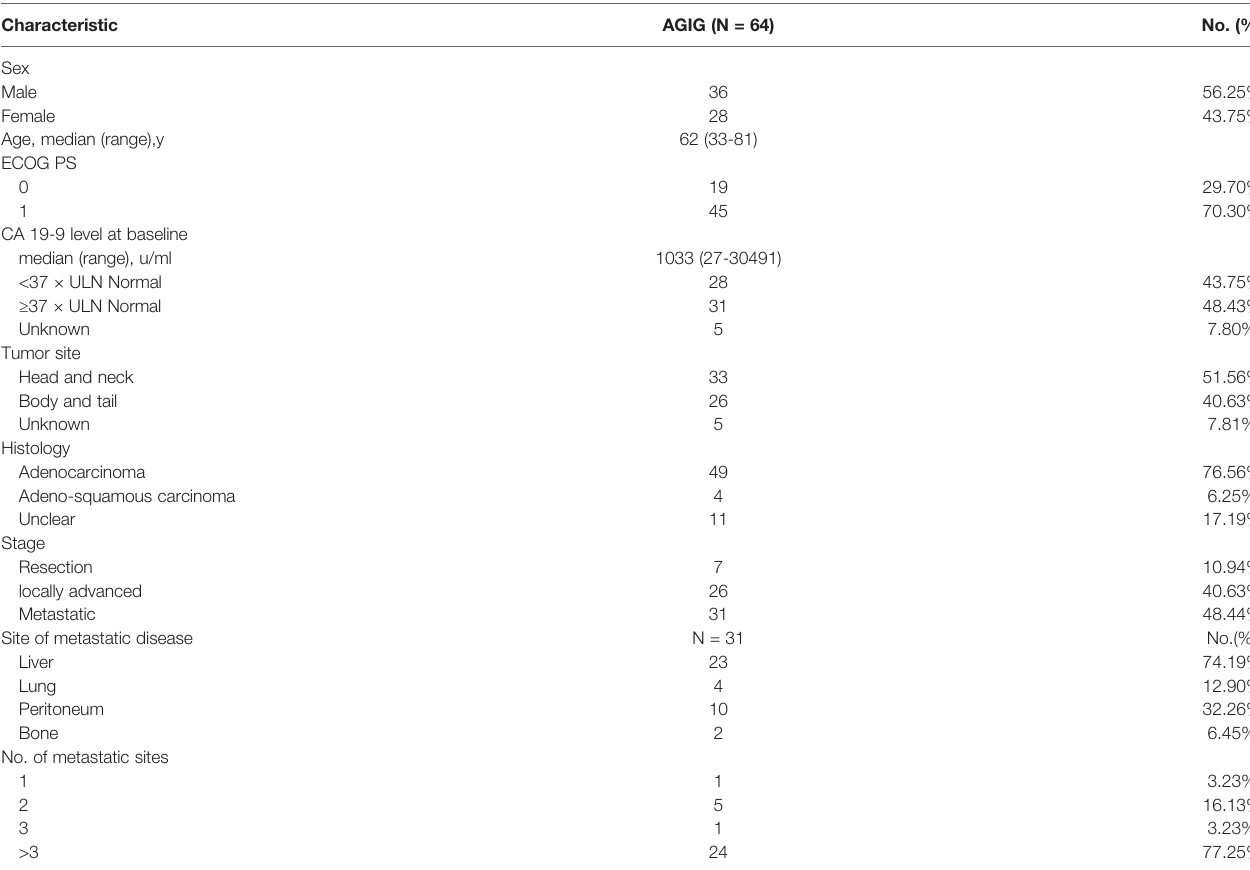
TABLE 1 | Baseline characteristics. (intention-to-treat population).